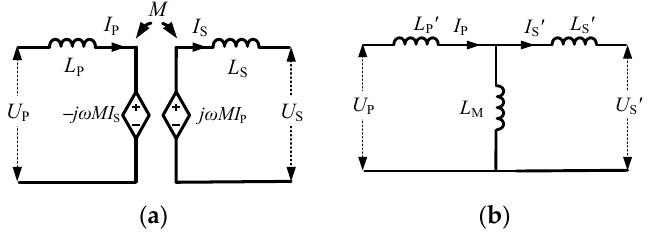
Figure 1. Analysis models of the loosely coupled transformer: ( a ) the mutual inductance model; ( b ) the transformer model.